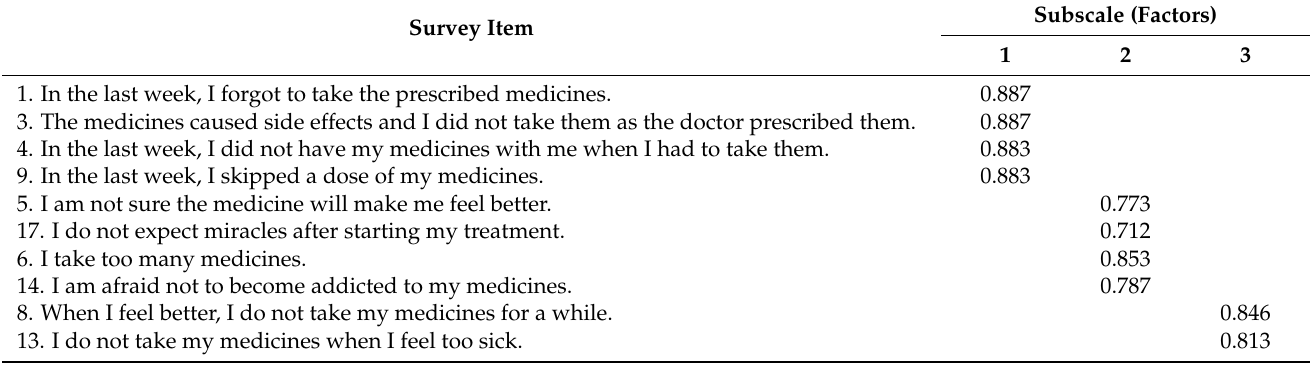
Table 5. Factor loadings for the survey items after Exploratory Factor Analysis. Survey Item